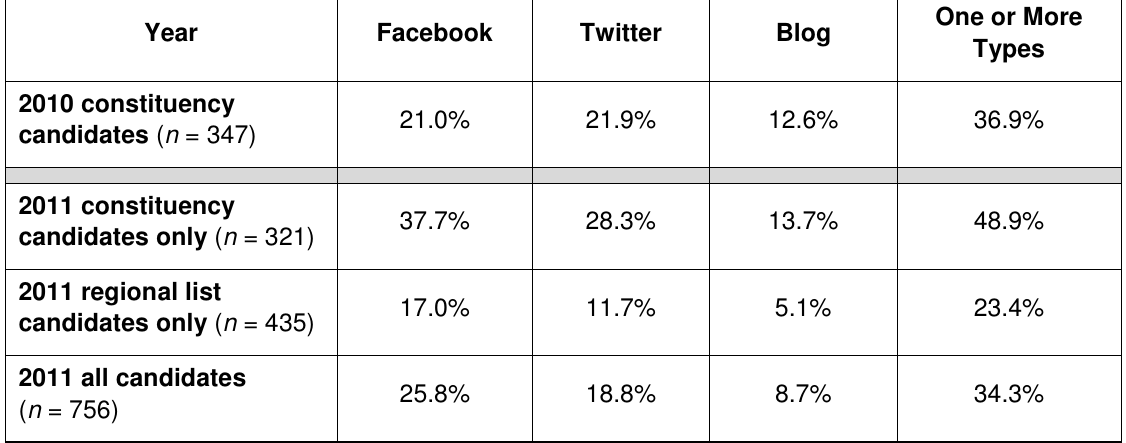
Table 3: Adoption of Social Media by Candidates,